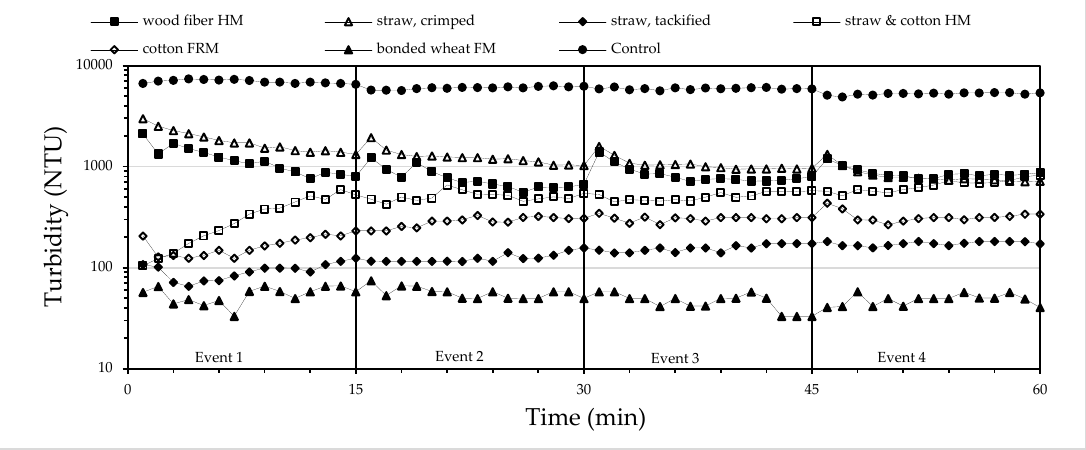
Figure 5. Average turbidity of surface runo ff vs. time. Average turbidity for each minute was calculated for all four replicate plots for each treatment.